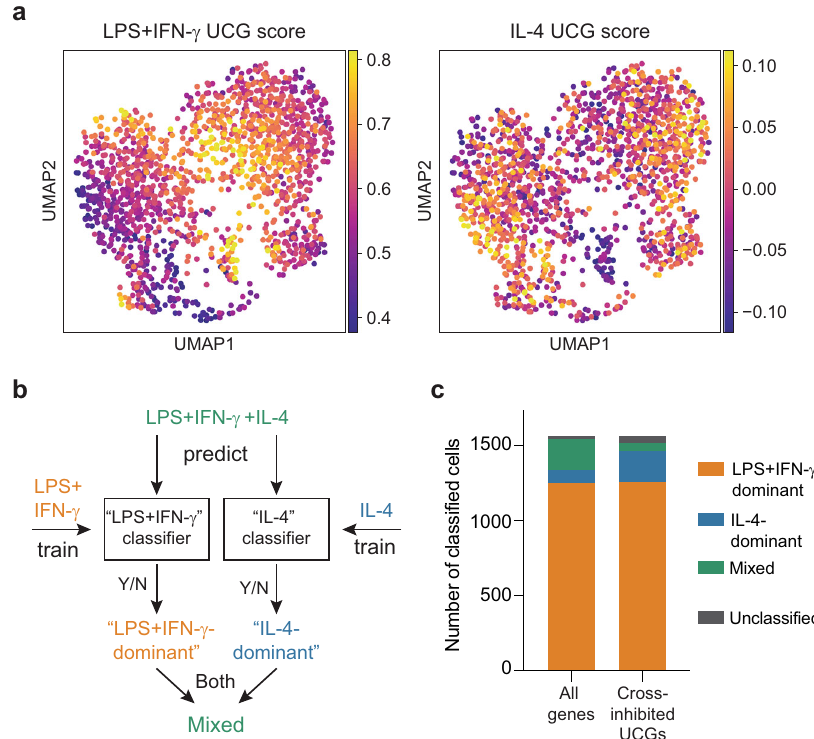
Fig. 3 Neural network classi fi er suggests cross-inhibited genes are selectively expressed in single cells after co-stimulation. a UMAP visualization of co-stimulated single cells, colored by the expression score of LPS + IFN- γ (left), or IL-4 (right) UCGs. b Schematic of the neural network classi fi ers built to categorize cells as LPS + IFN- γ -dominant, IL-4-dominant or Mixed. c Results of the neural network classi fi cation of the transcriptional state of co-stimulated cells. Bars represent the number of cells identi fi ed as LPS + IFN- γ -dominant (yellow); IL-4-dominant (blue); mixed (green); or unclassi fi ed (gray). The classi fi ers were trained on either all genes or UCGs that displayed cross-inhibition after co-stimulation. Source data are provided as a Source Data fi